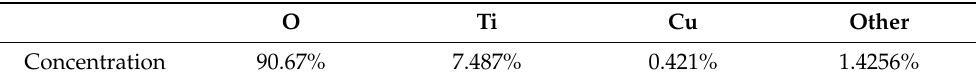
Table 3. Atomic composition computed from the sum of integral